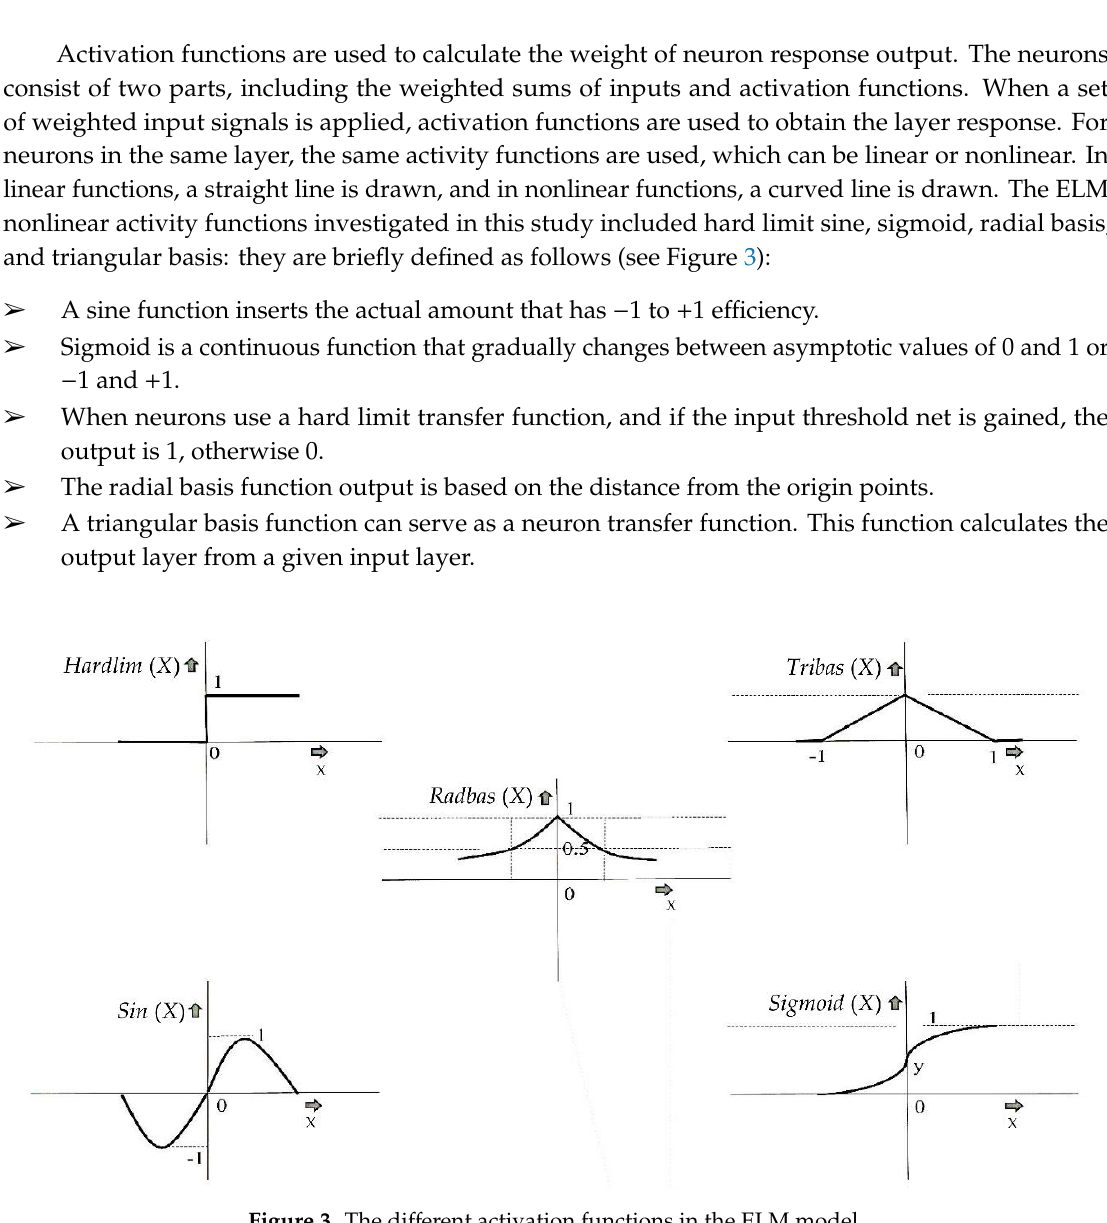
Figure 3. The different activation functions in the ELM model. Figure 3. The di ff erent activation functions in the ELM